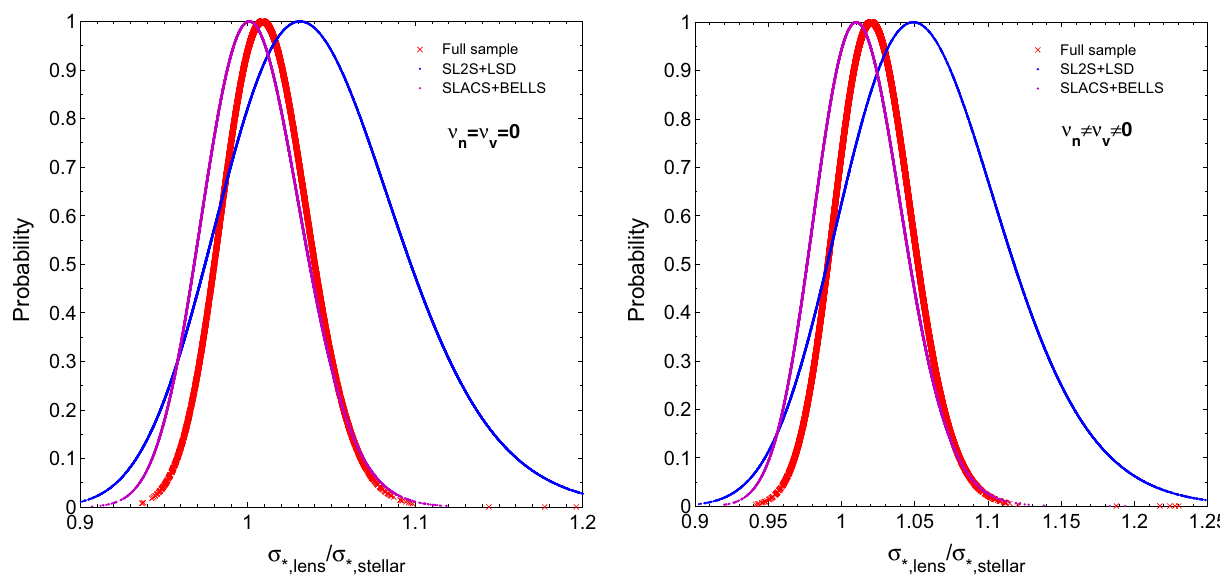
Fig. 7 Confidence limits on the ratio of the lensing based velocity dispersion to the stellar velocity dispersion Table 2 Summary of the lensing based characteristic velocity dispersion and its corresponding ratio to the stellar velocity dispersion, based on the lens redshift distribution of current strong lensing observations Galaxy evolution model